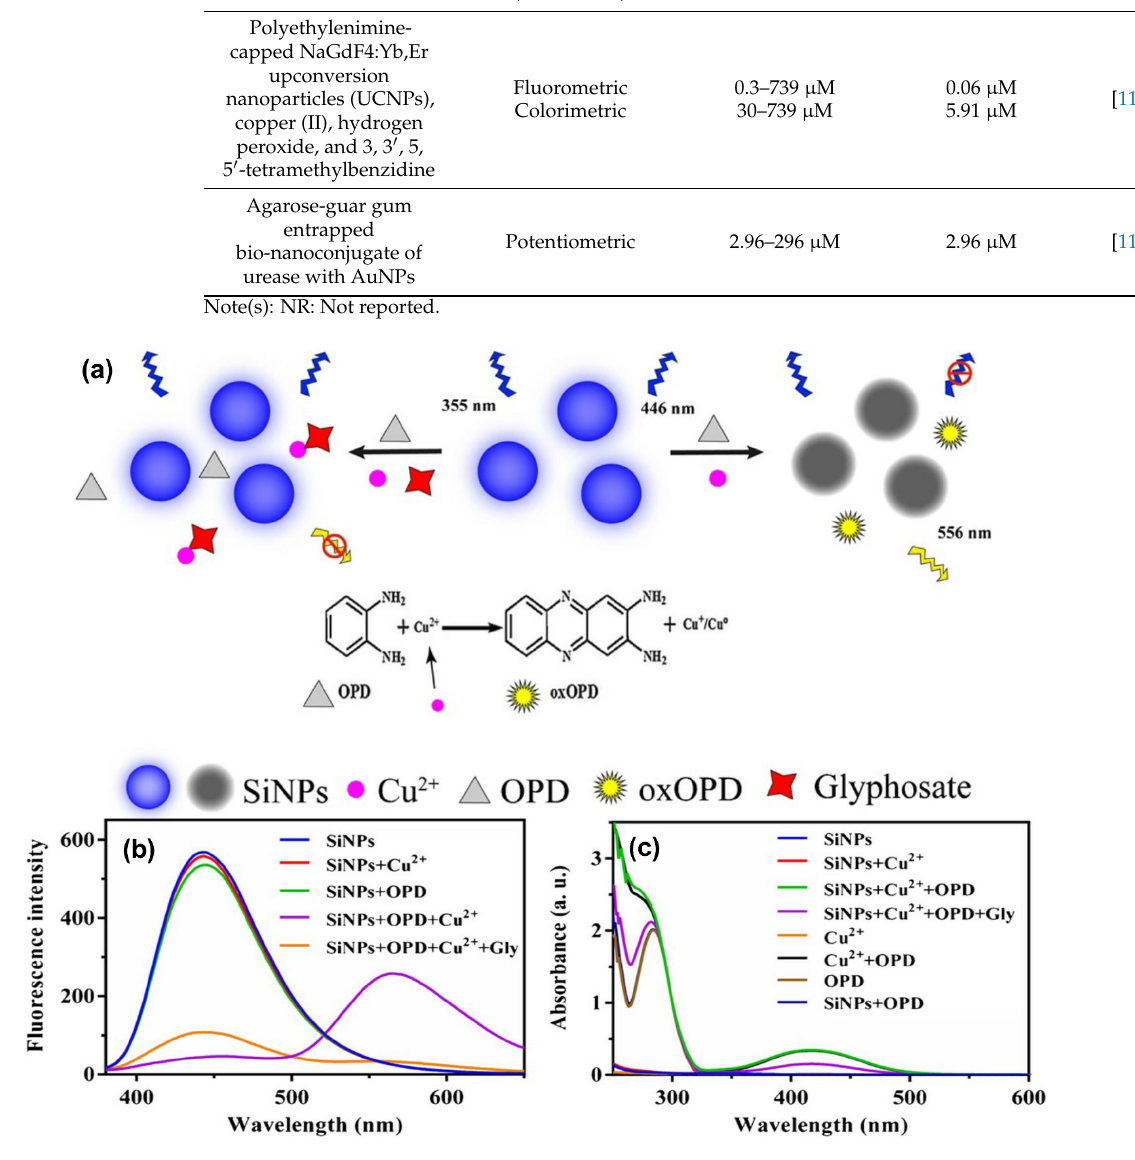
Figure 7. ( a ) Scheme of dual-signal sensing strategy based on ratiometric fluorescence and colorimetry for Cu 2+ and glyphosate determination. ( b ) Fluorescence spectra of SiNPs, SiNPs + Cu 2+ , SiNPs + OPD, SiNPs + OPD + Cu 2+ , and SiNPs + OPD + Cu 2+ +glyphosate. ( c ) UV–vis absorption spectra of SiNPs, SiNPs + Cu 2+ , SiNPs + Cu 2+ + OPD, SiNPs + Cu 2+ + OPD + glyphosate, Cu 2+ , Cu 2+ + OPD, OPD, and SiNPs + OPD. Reprinted/adapted with permission from [116]. Copyright 2022 Springer. Table 2. The 0D-nanomaterial metal-based nanoparticles as GLYP detection sensors.